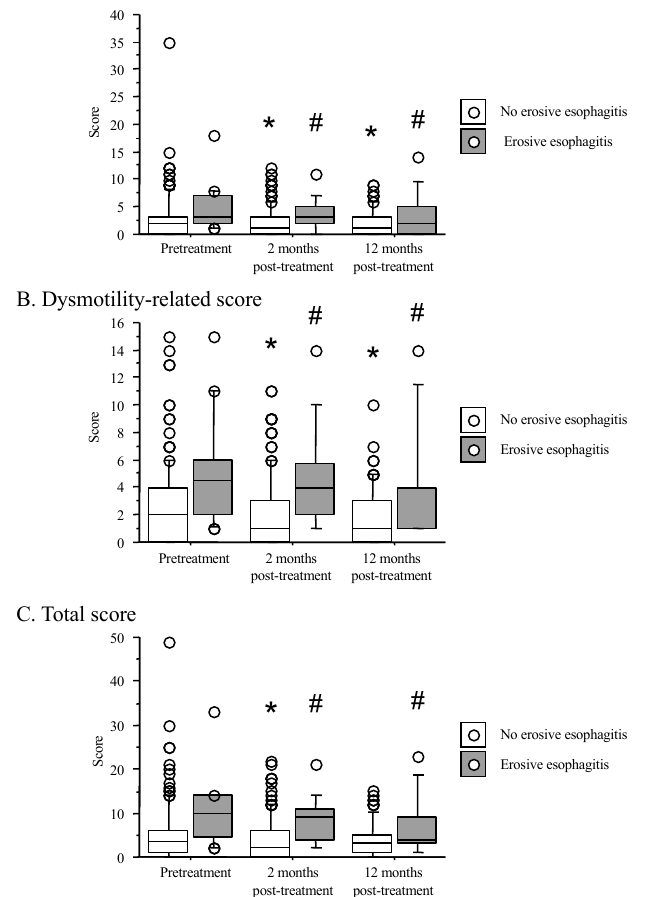
Figure 3. Correlation between F-scale questionnaire score and time course from baseline to 2 months after treatment and 12 months after eradication success between patients with reflux esophagitis and nonerosive esophagitis. Scores in the F-scale questionnaire are shown as acid-related ( A ), dysmotility-related ( B ), and total scores ( C ). *: p < 0.05 vs. score at pretreatment and #: p < 0.05 vs. score of patients with nonerosive esophagitis. 3.6. Risk Factors for Reflux Esophagitis after H. pylori Eradication Therapy Table 4. Association of category with reflux esophagitis and reflux-related symptoms before and after eradication therapy. On univariate analysis, risk factors for reflux esophagitis development were the total Category Before Eradication Therapy After eradication Therapy, 12 baseline F-scale score (OR: 1.069, 95% CI: 1.009–1.132, p = 0.02) and the dysmotility-related score of the F scale at pretreatment (1.200, 1.055–1.364, p < 0.01) (Table 5). Following mul- tivariate analysis using factors showing p < 0.2 in the univariate analysis (hiatal hernia and total score of F scale) and age and sex as adjustment factors, the total baseline F-scale score was again shown to be a significant risk factor (OR: 1.069, 95% CI: 1.003–1.139, p = 0.04) (Table 5).